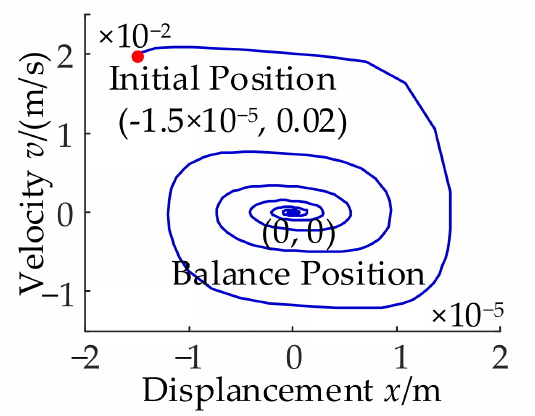
Figure 21. Phase trajectories by simulation when K p = −